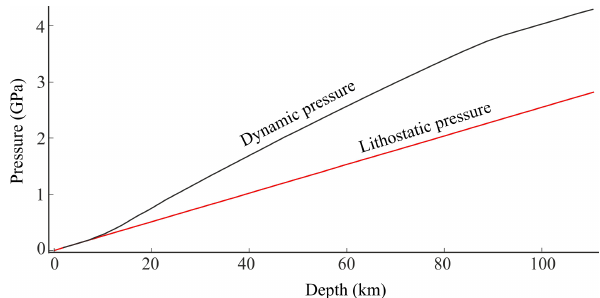
Figure A1. Evolution of dynamic and lithostatic pressures in a UTC with η = 10 21 Pas and ρ = 2800kgm − 3 . The ratio dynamic pressure/lithostatic pressure corresponds to the overpressure factor